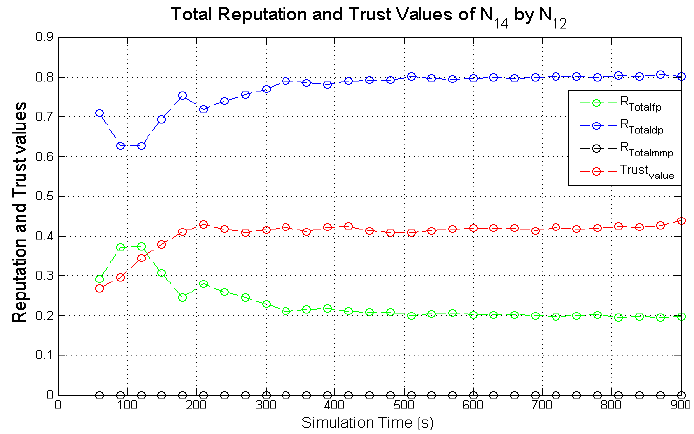
Figure 19. N 16 is selfish and dishonest, N 18 is benevolent and honest.